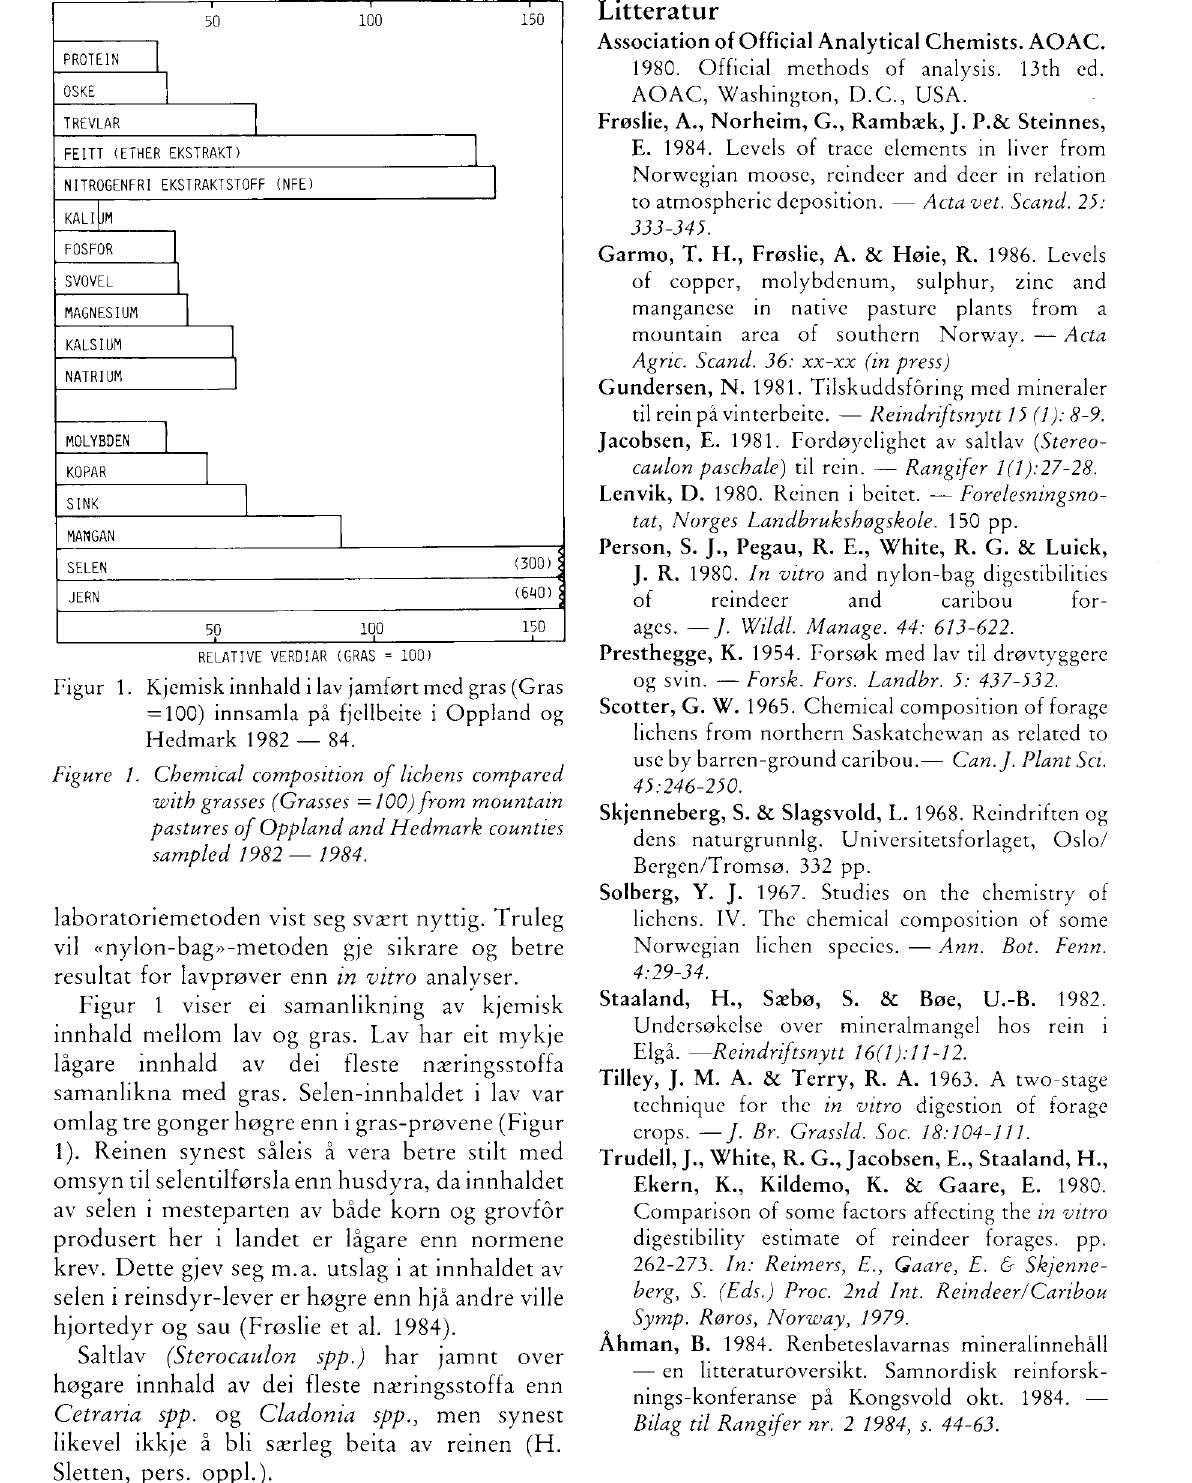
Cetraria spp. og Cladonia spp., men